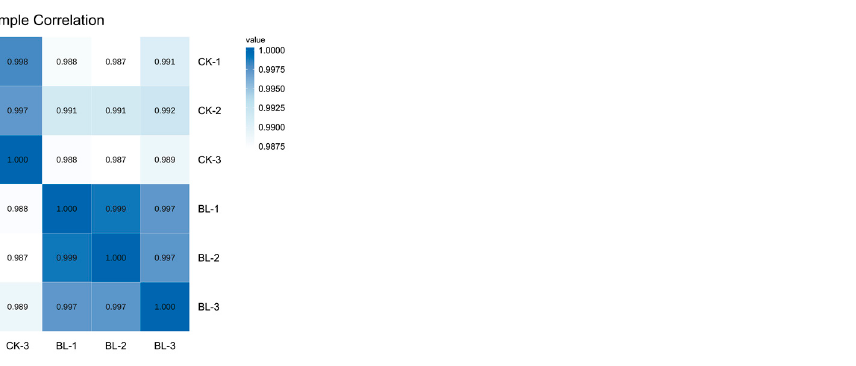
Figure 5. Sample correlation heat map. The abscissa and ordinate are each sample, and the color depth indicates the correlation coefficient between the two samples.